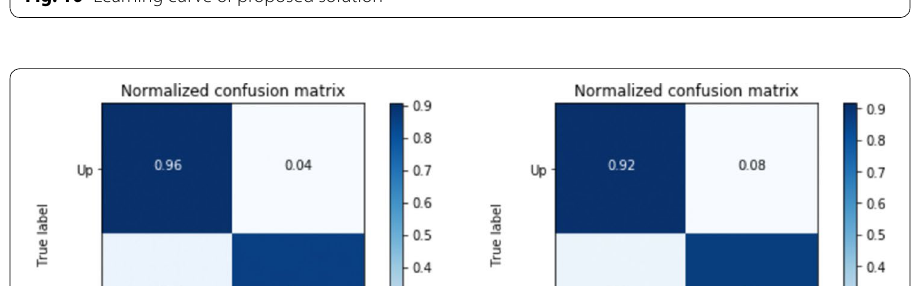
Fig. 10 Learning curve of proposed solution